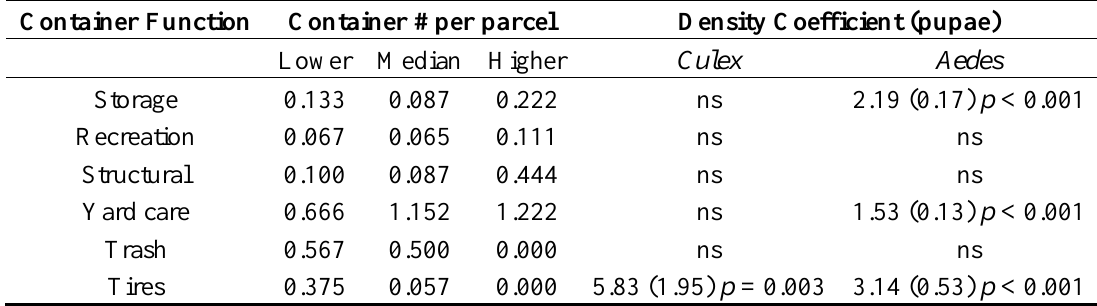
Table 2. Container composition and statistical results. Regression coefficients (mean with standard deviation) and p-value shown only if significantly different from 0.